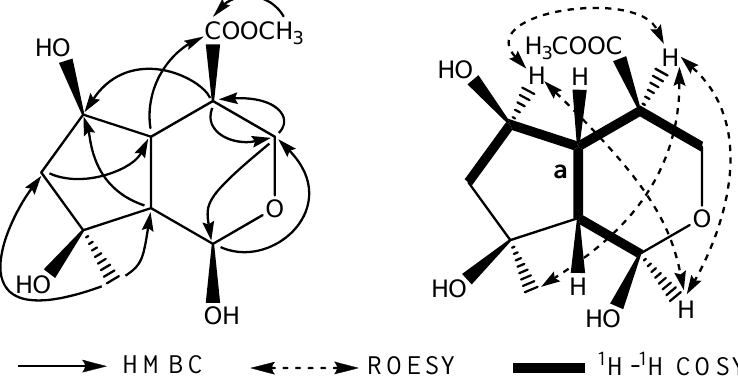
Figure 2. Key HMBC, ROESY and 1 H- 1 H COSY correlations of compound 1 .